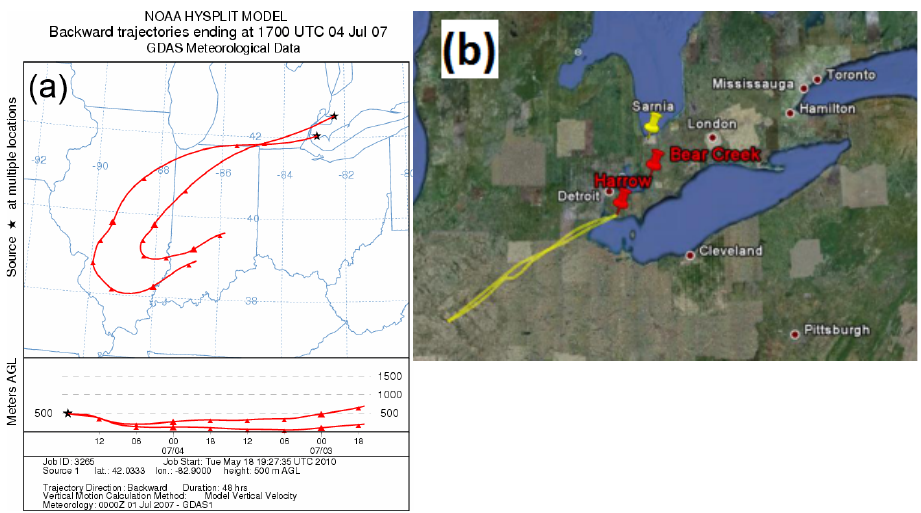
Fig. 5. Airmass sources during the Harrow-to-Bear Creek period (see Fig. 3, red period). (a) shows HYSPLIT back trajectories to the Harrow and Bear Creek sites. (b) shows high-resolution back trajectories to the Harrow site.